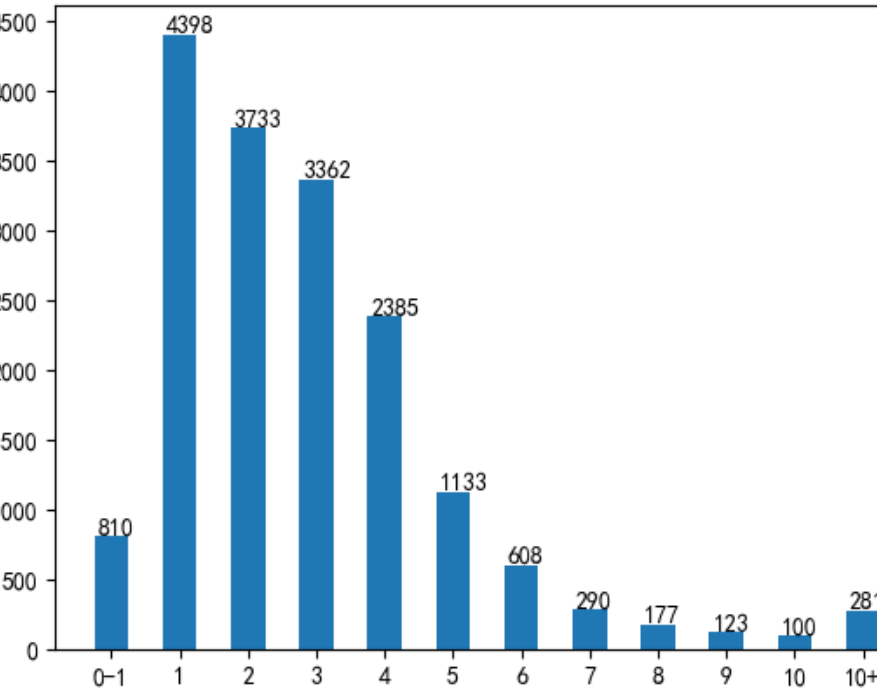
Figure 5. Age distribution of HFMD epidemic. the link (http://data.sheshiyuanyi.com/WeatherData/, accessed on 1 March 2020). x-axis is in